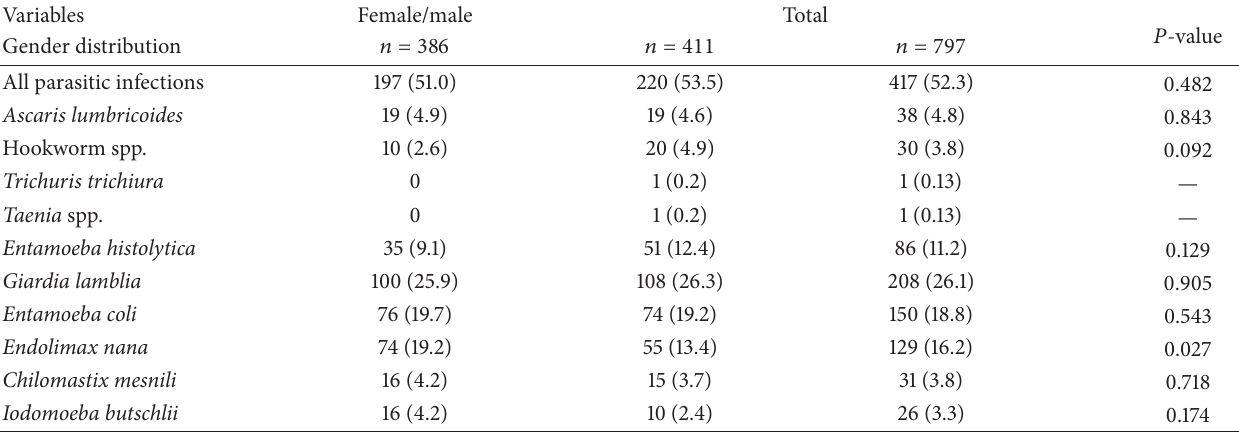
Table 2: Types and prevalence of intestinal parasites (percentages are in parentheses).